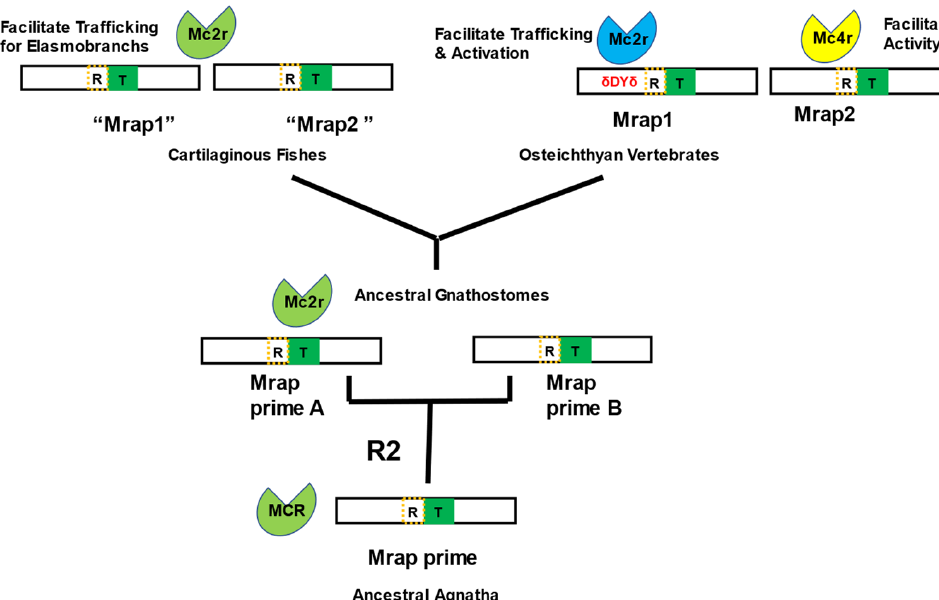
Figure 7. Proposed evolution of Mrap during the radiation of vertebrates. See text for explanation and discussion. Abbreviations: R—reverse topology motif in the N-terminal of Mrap; T—transmembrane domain in Mrap; R2—second chordate genome duplication event.